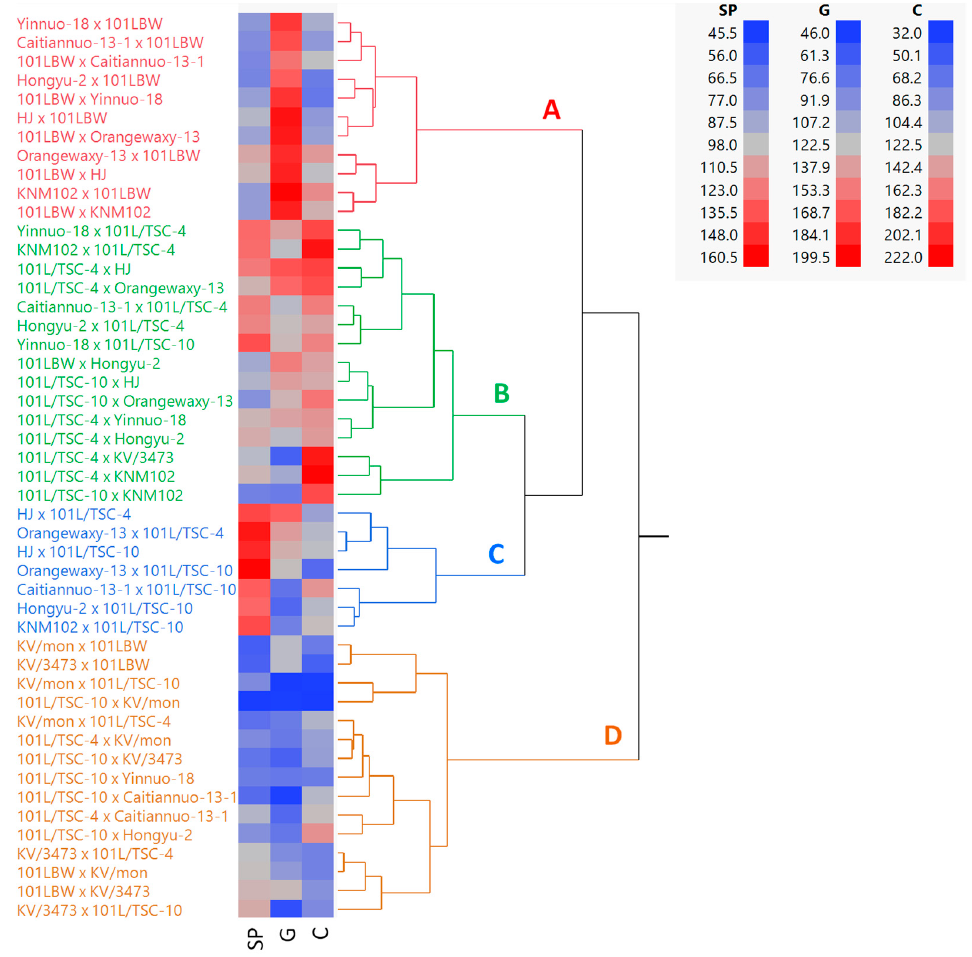
Figure 2. Overall rank-sum (ORS) in the dry season based dendrogram revealing phenotypic variabilities of 48 sweet-waxy corn hybrids in responses to 3 groups of preferences. SP overall rank-sum based on seed producer’s perspective. G overall rank-sum based on grower’s perspective. C overall rank-sum based on consumer’s preference. Blue bars in each column indicate a lower ORS, whereas red bars in each column for a higher ORS. Table 6. Overall rank-sum index (ORSI) of top 5 crosses among 48 possible crosses.